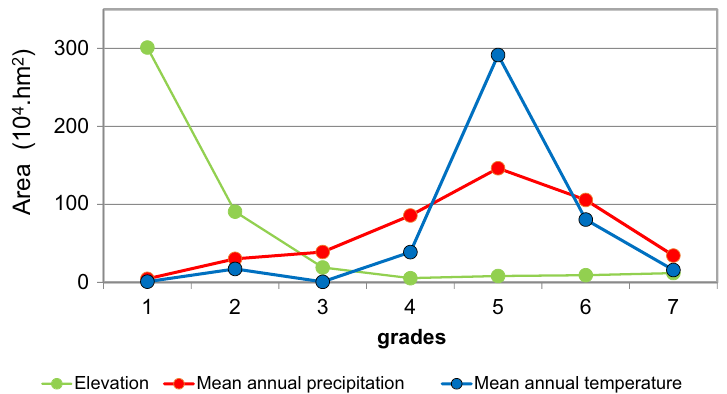
Figure 2. Area of eucalyptus plantations in China based on grades defined in text.